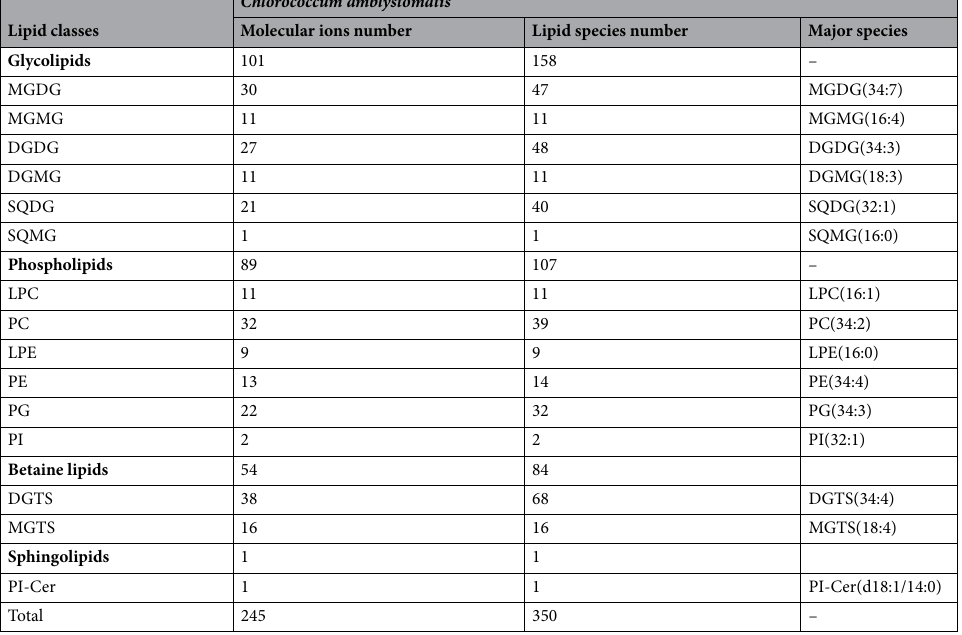
Table 2. Polar lipid classes identified in the total lipid extract of Chlorococcum amblystomatis by HILIC–HR– ESI–MS and MS/MS. The total number of molecular ions, lipid species identified in each class and lipid species per class is shown. MGDG monogalactosyldiacylglycerol, MGMG monogalactosylmonoacylglycerol, DGDG digalactosyldiacylglycerol, DGMG digalactosylmonoacylglycerol, SQDG sulfoquinovosyl